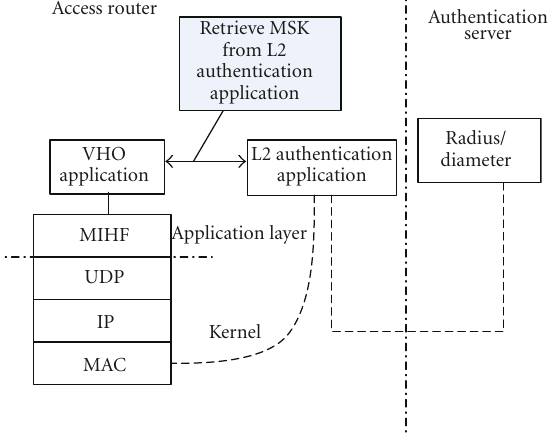
Figure 18: Software architecture for